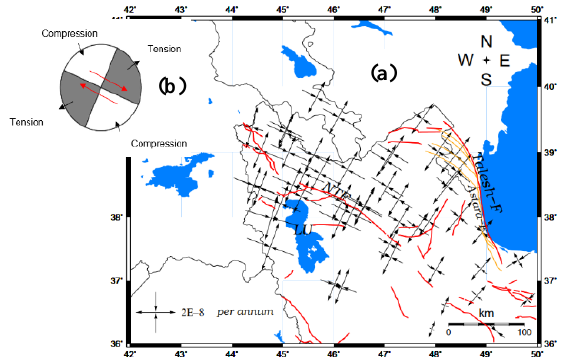
Figure 3. (a) The deduced direction of maximum principal axes of strain rates. (b) focal mechanism of a right-lateral strike-slip motion.